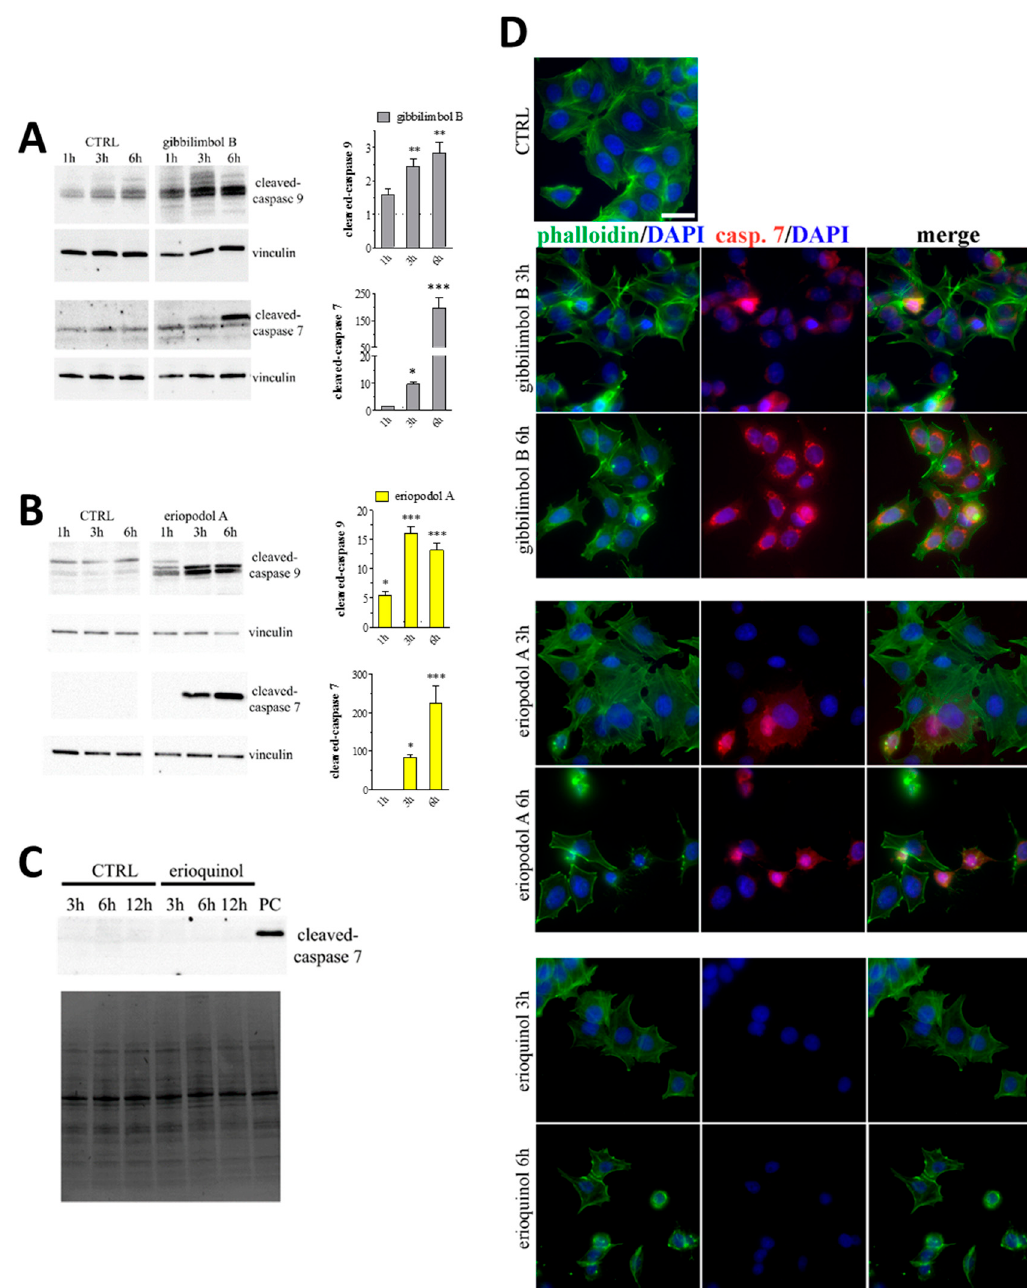
Figure 6. Piper genus-derived compounds induce cell death. Western blot analysis of cleaved-caspase 9 and 7 in MCF7 cells treated for increasing times in the absence (CTRL, control) and in the presence of ( A ) gibbilimbol B or ( B ) eriopodol A. Vinculin was used as internal standard. Right panels: densitometric analysis expressed as fold change of CTRL. Images and data are representative of three-five independent experiments. * p < 0.01, ** p < 0.001, and *** p < 0.0001 relative to CTRL. ( C ) Western blot analysis of cleaved-caspase 7 in MCF7 cells treated for increasing times in the absence (CTRL) and in the presence of 10 µ g / mL erioquinol. The stain-free gel was used as loading control. Images are representative of three independent experiments. PC: positive control. ( D ) Immunofluorescence imaging of cleaved-caspase 7 (punctate red pattern) in MCF7 cells treated for 3 and 6 h in the absence (CTRL) and in the presence of gibbilimbol B / eriopodol A (30 µ g / mL) or erioquinol (10 µ g / mL). 4’,6-diamidine-2’-phenylindole dihydrochloride (DAPI) (blue) and phalloidin (green) were used for nuclei and cytoskeleton detection, respectively. Images are representative of four independent experiments. Scale bar = 25 µ m.